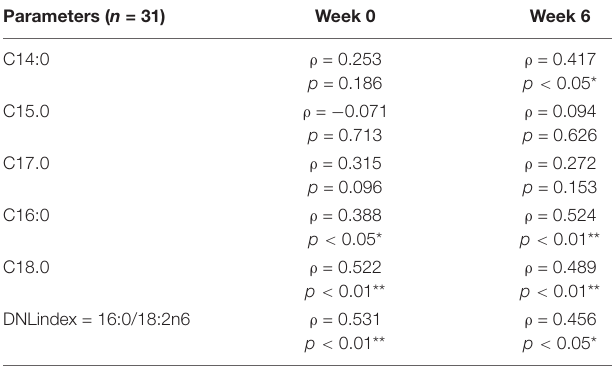
TABLE 4 | Correlations between GCGN and FFA and DNL-index before (Week 0) and after (Week 6) HPD intervention.